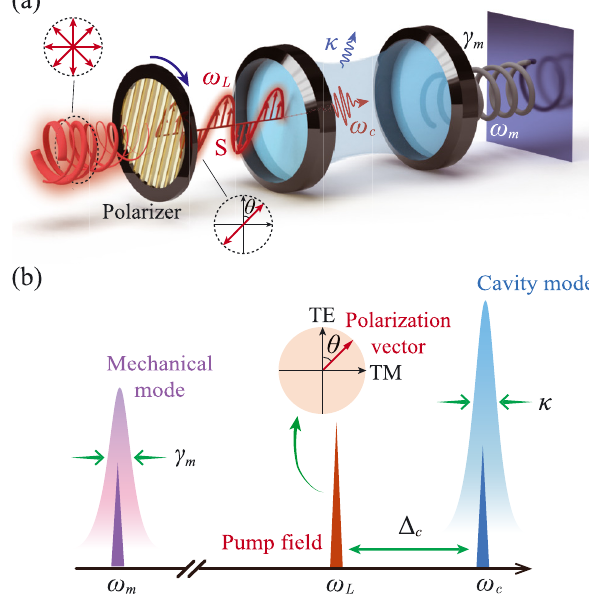
Figure 1: Vector optomechanical entanglement in a polarized- light-driven COM resonator. (a) Schematic diagram of a polarized-light-driven